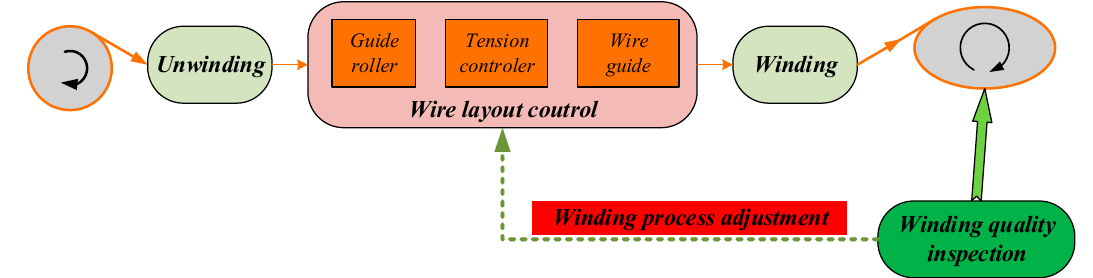
Figure 1. The production process of high voltage primary